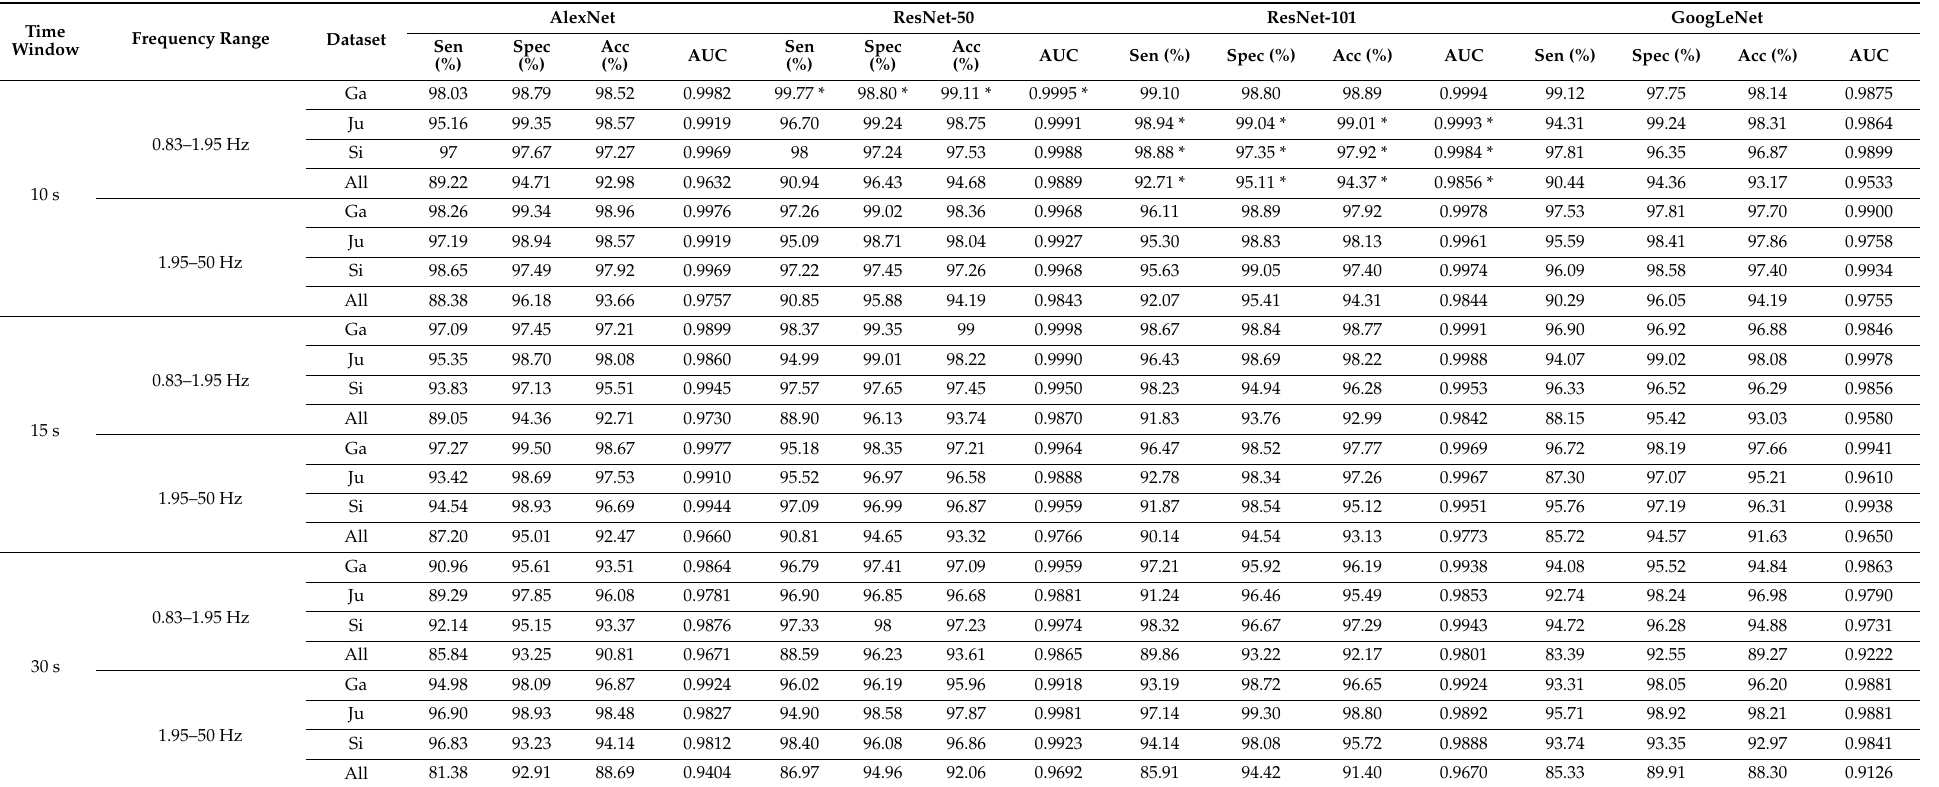
Table 19. Two-class classification of CF for CO and PD (Class 2, Class 2.5, and Class 3) using several CNN classifiers (AlexNet, ResNet-50, ResNet-101, and GoogLeNet) with 10-fold